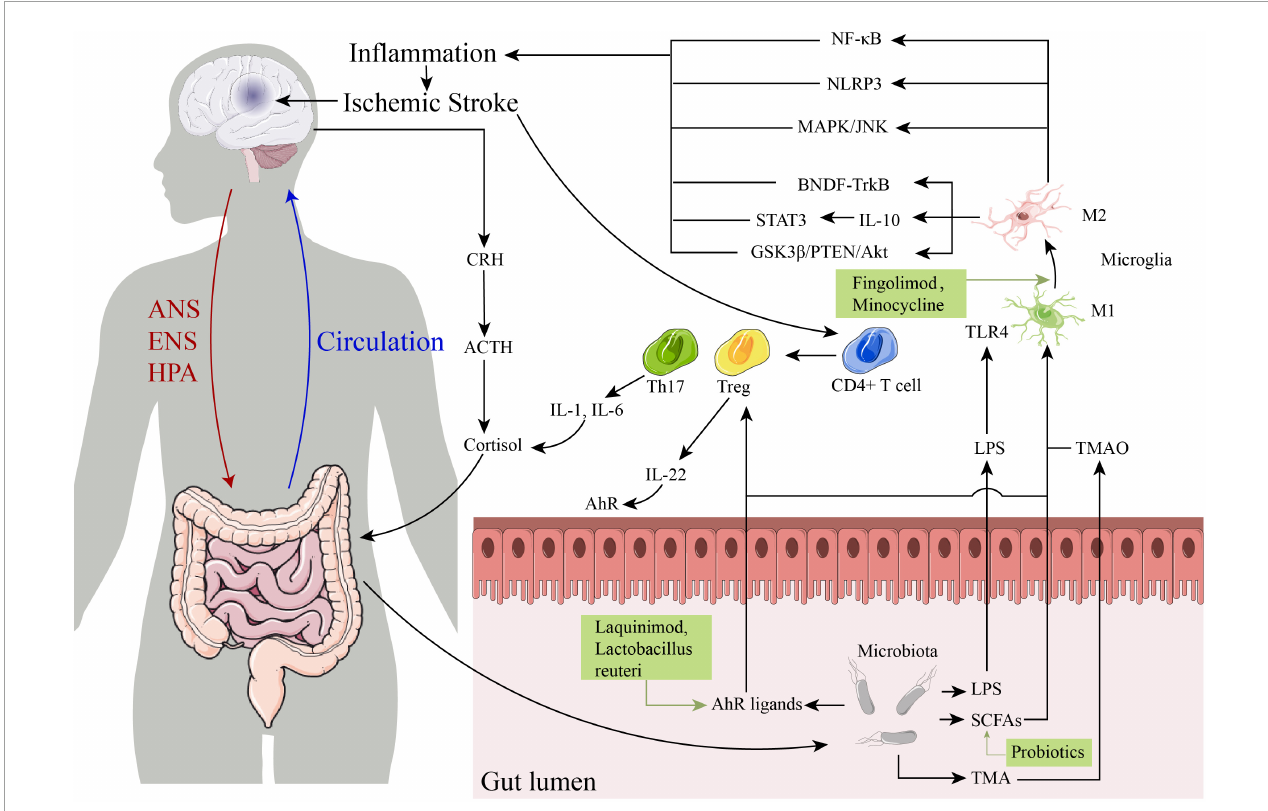
FIGURE1 The specific immune-related pathways in the post-ischemic stroke (IS) gut-brain axis and some drugs that targeting gut-brain axis of IS. ANS, autonomic nervous system; ENS, enteric nervous system; HPA, hypothalamic-pituitary-adrenal; CRH, corticotropin-releasing hormone; ACTH, corticotropin-releasing hormone; IL, interleukin; TLR4, toll-like receptor 4; LPS, lipopolysaccharide; SCFAs, short-chain fatty acids; TMA, trimethylamine; TMAO, trimethylamine N-oxide; NF- κ B, nuclear factor kappa B; NLRP3, NOD-like receptor thermal protein domain associated protein 3; AhR, aryl hydrocarbon